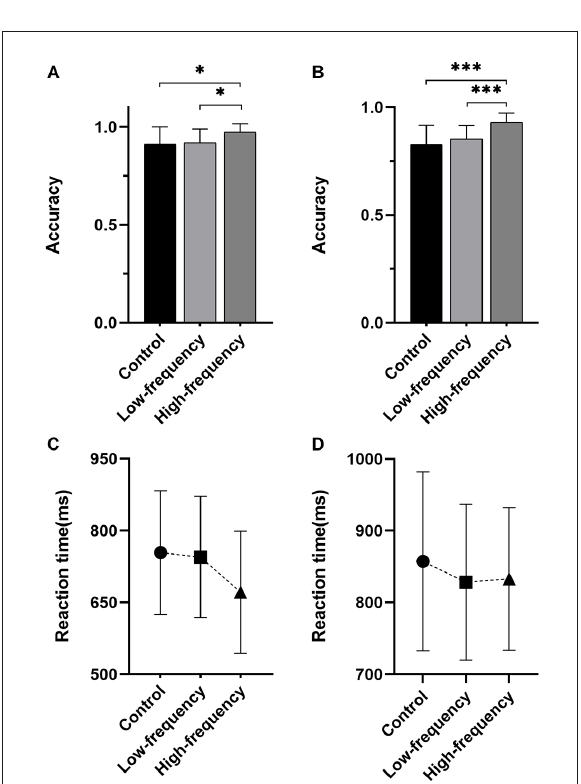
FIGURE2 Results of the N-back task. (A) The accuracy of the 0-back task, (B) the accuracy of the 1-back task, (C) the reaction time of the 0-back task, (D) the reaction time of the 1-back task. ∗ Statistically significant with P < 0.05, ∗∗∗ statistically significant with P < 0.001.